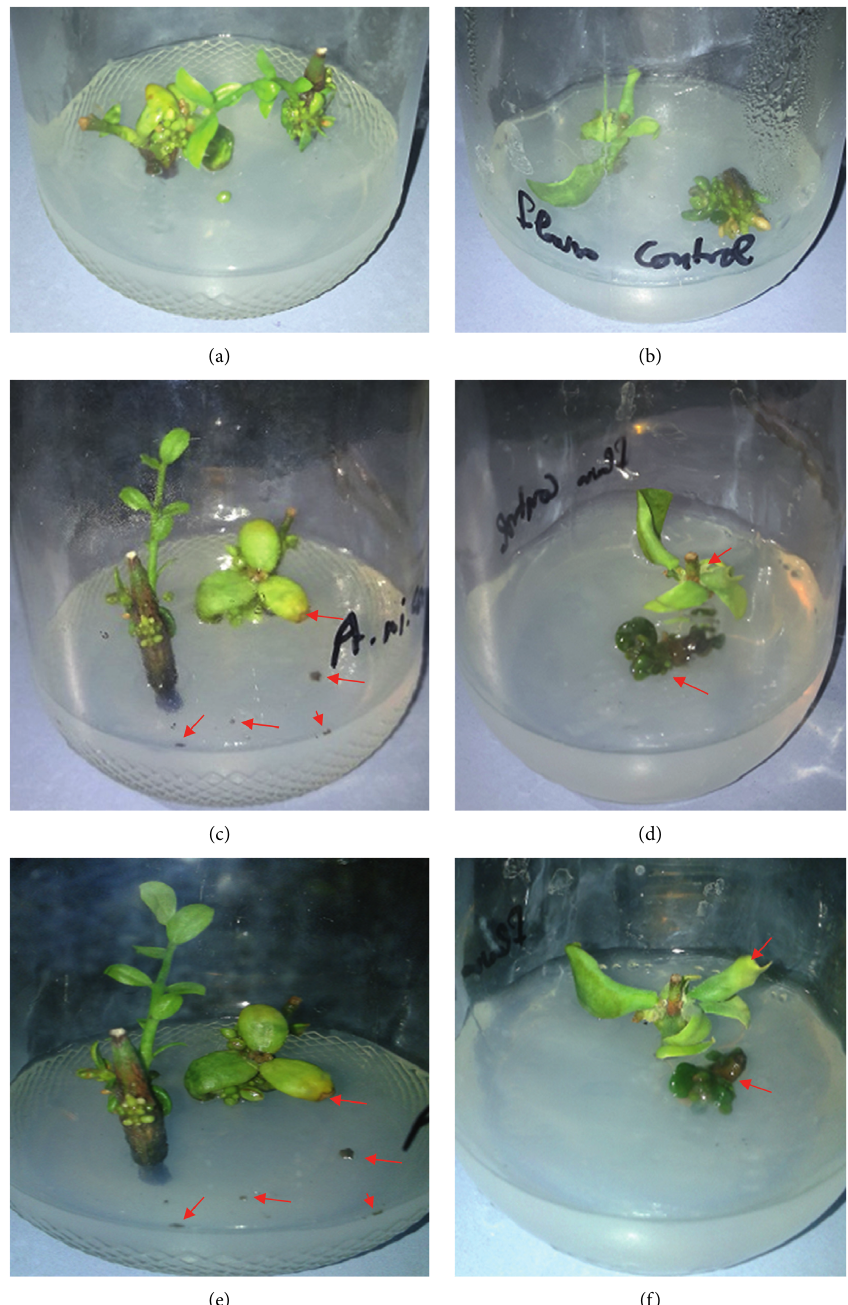
Figure 2: Jojoba grown in tissue culture and infected with either A. niger or A. flavus cells without any further treatments. (a), (c), and (e) Plant at days 0, 5, and 10, respectively, after spraying with A. niger cells. (b), (d), and (f) Plant at days 0, 5, and 10, respectively, after spraying with A. flavus cells. Red arrows refer to fungal growth. In case of A. flavus , plant nearly stopped